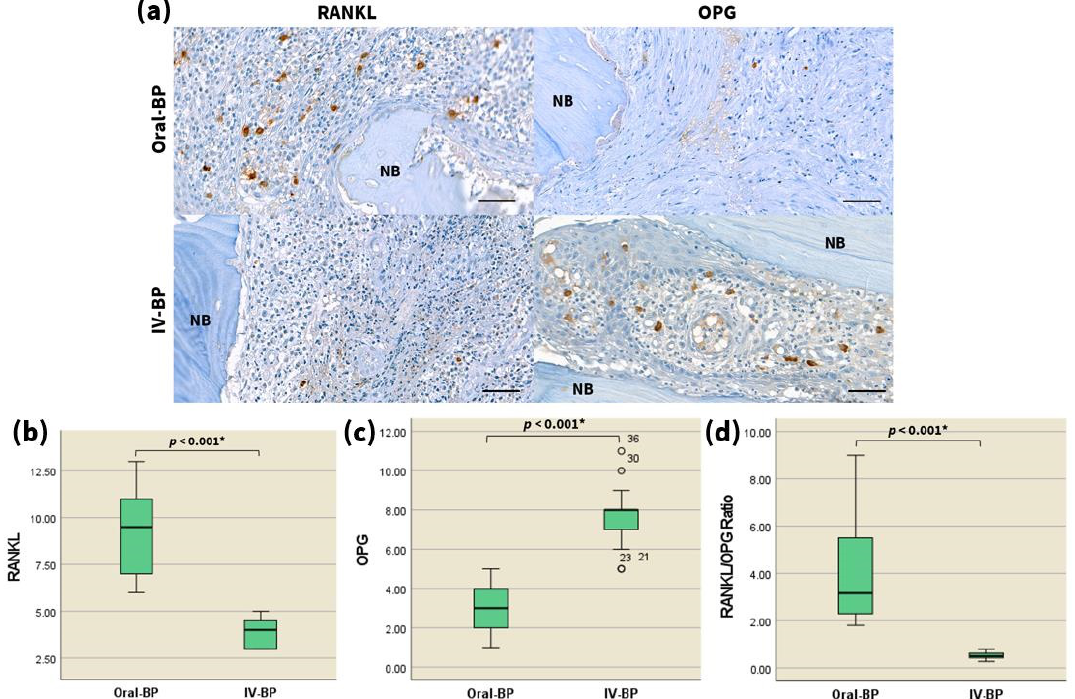
Figure 2. The RANKL/OPG ratio is decreased in the necrotic bones of IV BP-induced advanced-stage MRONJ patients. ( a ) High-magnification images (400 × ) of the immunohistochemistry analysis of RANKL (left) and OPG (right) expression in the specimens of the two patient groups as indicated. Scale bars = 50 µ m. Statistical analysis of the number of RANKL- positive ( b ), and OPG-positive ( c ) cells, and the RANKL/OPG ratio ( d ), via the Mann – Whitney U test ( n = 20 per group). ° marks statistical outliers. For detailed data, see Table 2. * p <